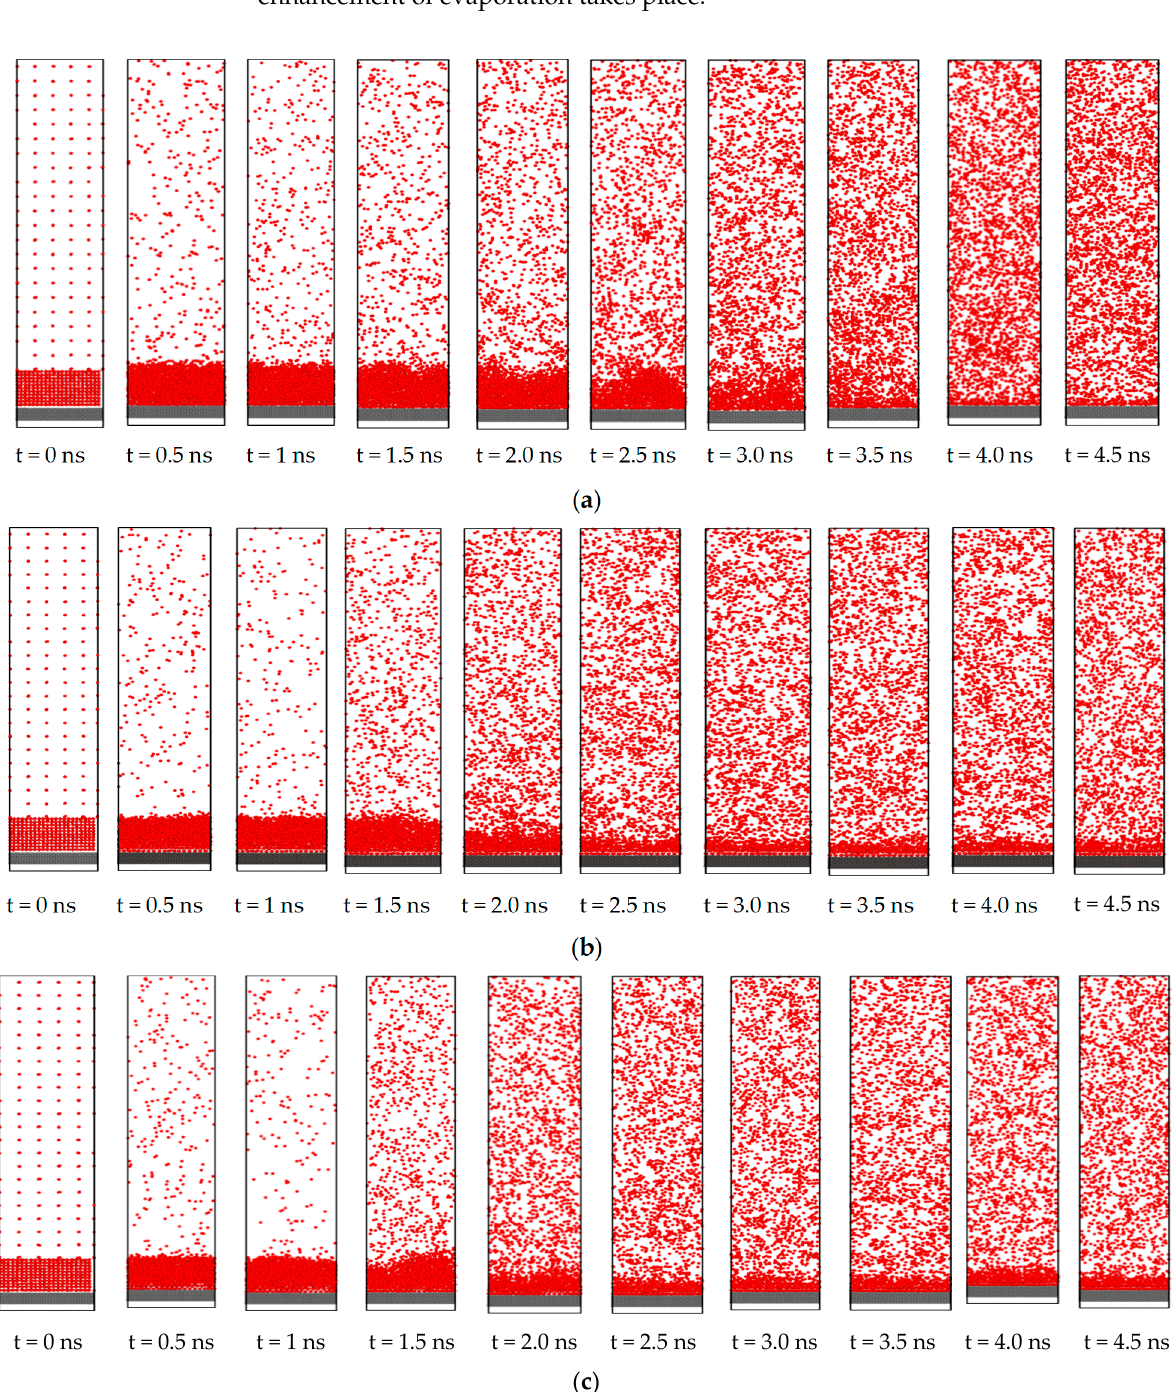
Figure 6. Simulation snapshots in the (x-y) plane for different wetting conditions. Wetting factor = 0.1 ( a ), 0.5 ( b ), 1.0 ( c ). The temperature history of the argon atoms is shown in Figure 7. It is observed that argon atoms take more time to reach equilibrium with the solid wall temperature for the hydrophobic condition (wetting factor = 0.1). When the wetting condition changes, argon takes less time to reach the equilibrium condition with the solid wall. The rapid increase of temperature in the case of a hydrophilic condition (wetting factor = 1.0) indicates that energy is transferred more quickly from the solid wall to liquid due to better solid-liquid interaction. From the temperature history of argon atoms, it can easily be said that more heat transfer takes place where the surface is more hydrophilic. Hence, transforming the